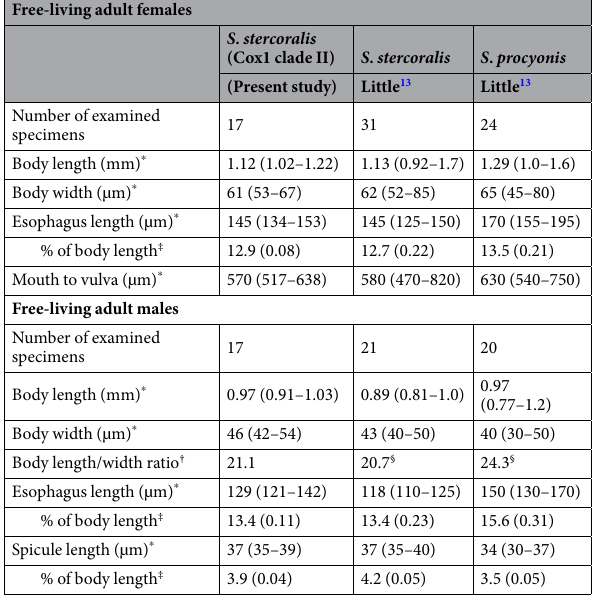
Table 6. Morphometric analysis on S . stercoralis isolated from dog feces in Myanmar. The values are expressed as either actual number [not marked], mean (range) [marked with * ], mean [marked with † ] or mean (standard error) [marked with ‡ ]. § These values were calculated by using the mean length and width data reported in Little 13 .